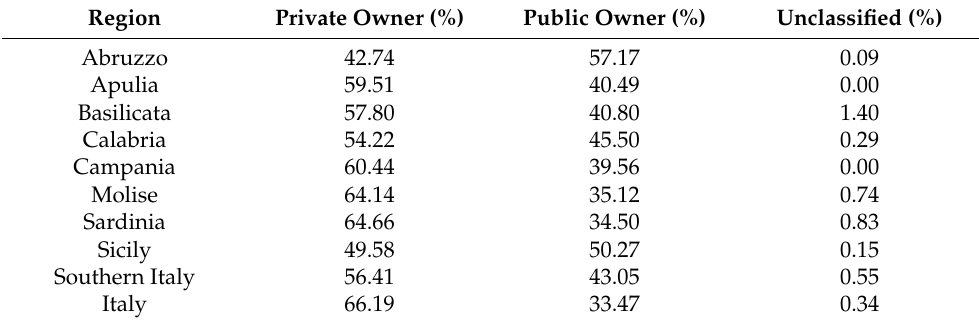
Table 5. Accessibility of forests in Southern Italy, 2005 data [29]. Partially adapted from